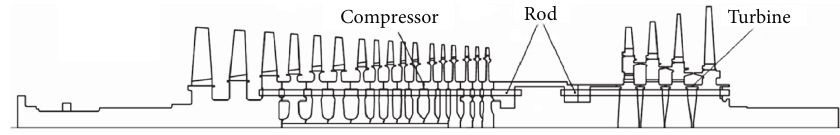
Figure 1: Rod fastened rotor